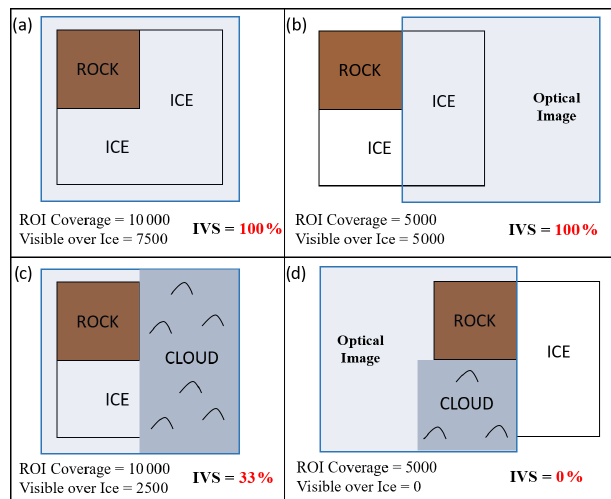
Figure 4. Schematic illustrations of four different image visibility scenarios, highlighting the IVS for each example. The black square boxes show an ROI tile, representing a 100km × 100km area. The same ROI tile is used in each example, comprising 7500km 2 of ice (this is the “clear-sky” ice mask value) and 2500km 2 of rock. Blue boxes represent Landsat optical image tiles, which cover all (a, c) or half (b, d) of the ROI. Optical images in (a) and (b) are cloud free, whilst images in (c) and (d) are partially cloud covered. The numbers below each example signify the following. (i) ROI cov- erage is the area (km 2 ) of the ROI that is covered by the optical image, (ii) visible over ice is the area (km 2 ) of ice within the ROI that is visible in the satellite image and (iii) IVS is the image visibil- ity score. The IVS score in each example is given as a percentage. This is calculated by dividing the “visible over ice” area by the area of the “clear-sky” ice mask within the ROI (7500 in this example). Note how each IVS gives a combined measure of ROI coverage, cloud extent and the proportion of ice within the ROI.